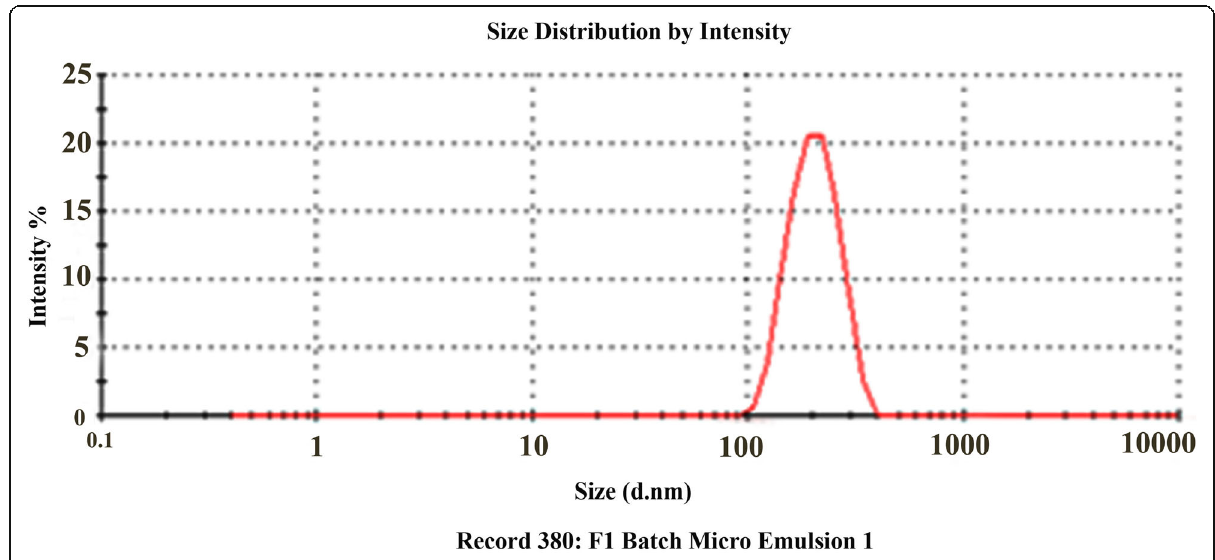
Fig. 3 Size distribution curve of microemulsion system